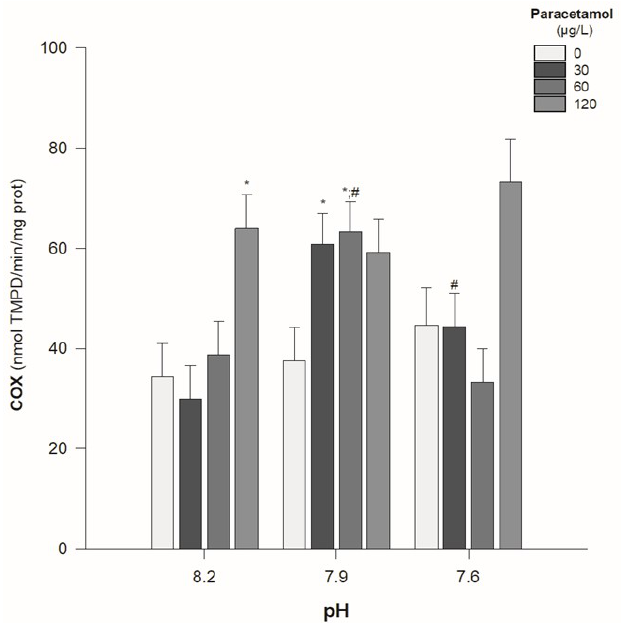
Figure 5. Cyclooxygenase (COX) activity in Hediste diversicolor exposed to paracetamol (0, 30, 60, and 120 µg/L) under the pH values of 8.2, 7.9, and 7.6. Statistical differences among PAR concentrations (30, 60, and 120 µg/L) and the control group (0 µg/L) are represented with “*”. Statistical differences between pH treatments (7.9 and 7.6) and the pH control group (8.2) within each PAR concentration are represented with “#”. Statistics refer to Dunnett’s tests (following a Two-Way ANOVA). Values are mean ± standard